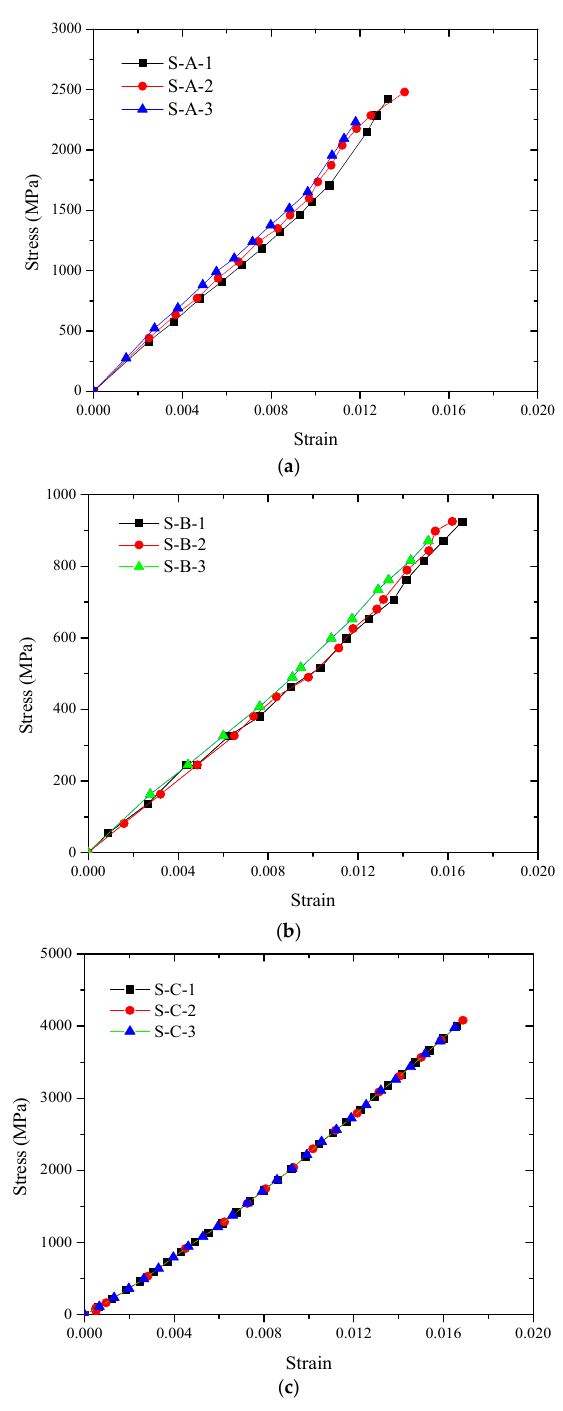
Figure 1. Tensile stress–strain curves of FRP flat sheets: ( a ) AFRP specimens, ( b ) BFRP specimens, and ( c ) CFRP specimens. ( c ) CFRP